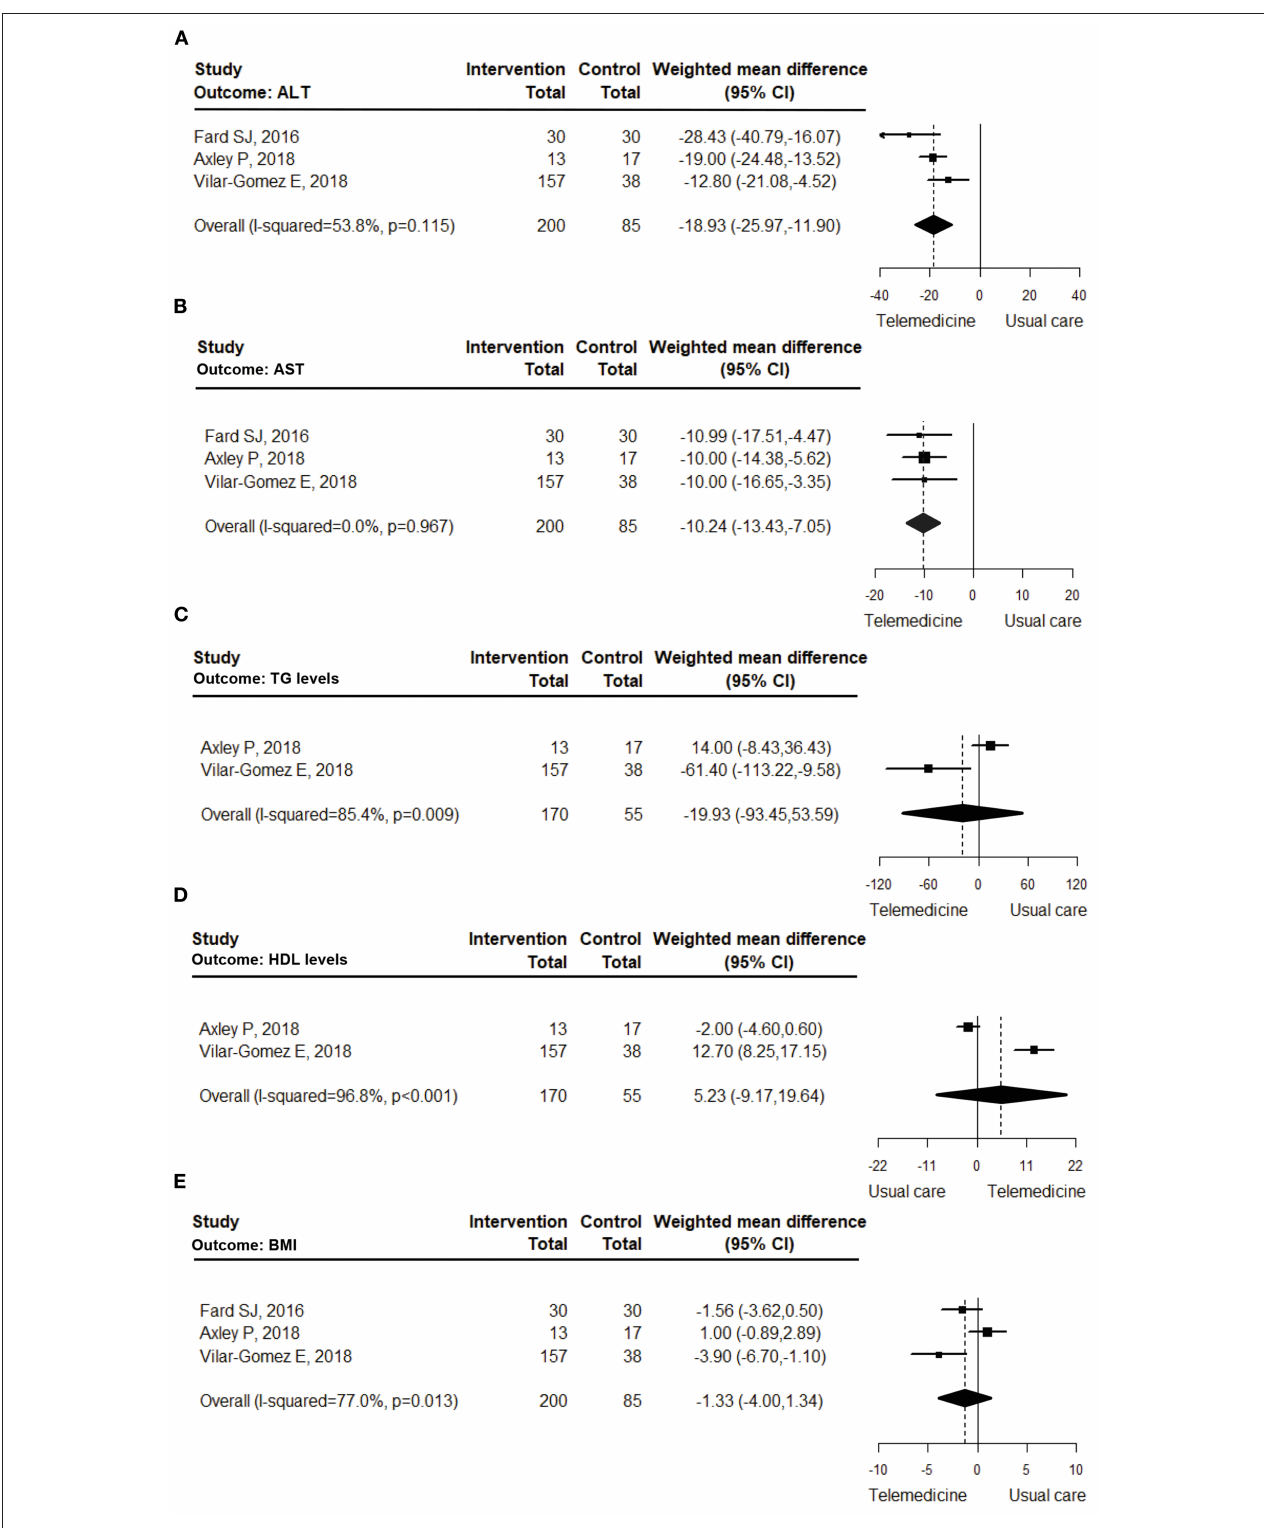
FIGURE 2 | Forest plot of the effects of telemedicine compared with usual care on the ALT (A) , AST (B) , triglyceride (C) , HDL-C (D) , and BMI (E) levels of obese patients with NAFLD.